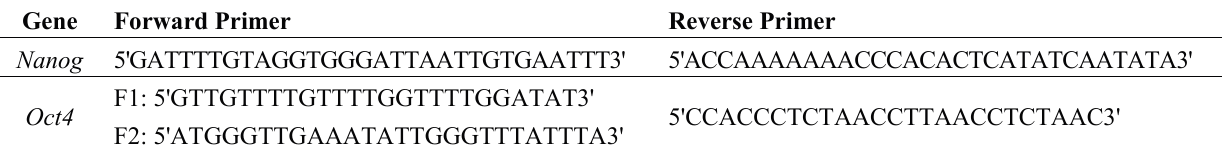
Table 3. Primers used for DNA methylation (bisulfite